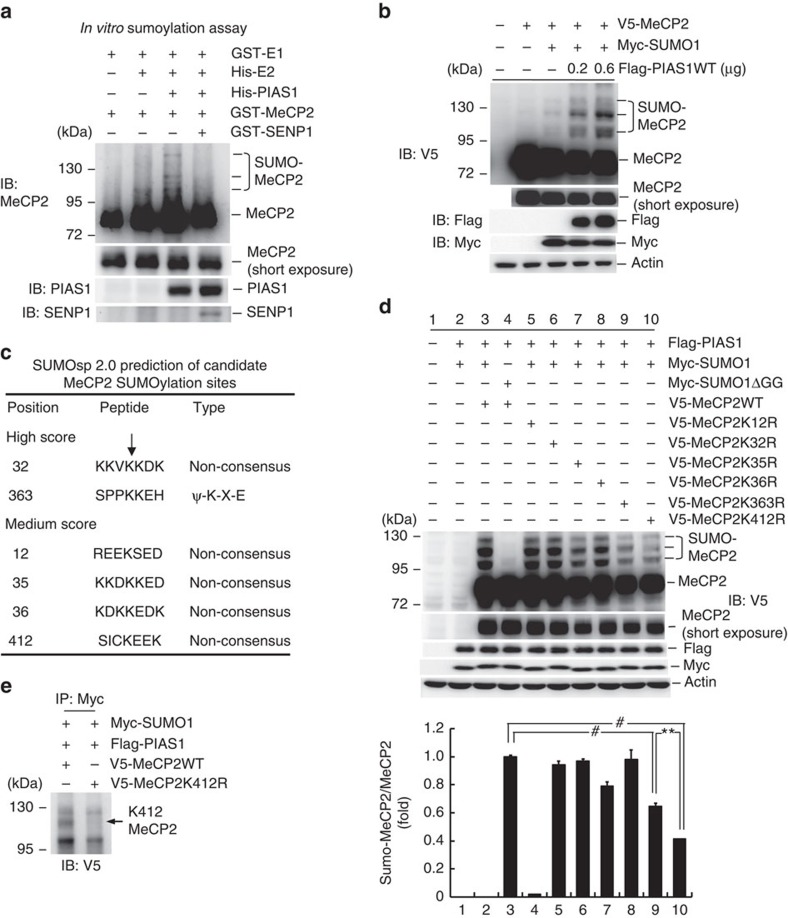
Identification of candidate SUMO sites on MeCP2.(a) In vitro SUMOylation assay showing MeCP2 SUMOylation by PIAS1. Purified GST-E1, His-E2, His-PIAS1, GST-MeCP2 and GST-SENP1 proteins were added to the reaction for this assay. (b) V5-MeCP2 and Myc-SUMO1 plasmids were co-transfected with different amounts of Flag-PIAS1 plasmid to HEK293T cells confirming MeCP2 SUMOylation by PIAS1. (c) SUMO2.0 Software prediction of candidate SUMO acceptors on MeCP2. The ‘K' letter indicated by the arrow represents the candidate SUMO sites. (d) Flag-PIAS1 and Myc-SUMO1 (or Myc-SUMO1ΔGG) plasmids were co-transfected with V5-MeCP2WT or different V5-MeCP2 lysine mutant plasmids to HEK293T cells. MeCP2 SUMOylation was examined by immunoblotting using anti-V5 antibody. The quantified result is shown in the lower panel (n=2 each group; F9,10=240.59, #P<0.001; q=12.73, #P<0.001 comparing lane 3 versus lane 9; q=21.1, #P<0.001 comparing lane 3 versus lane 10; q=8.37, **P<0.01 comparing lane 9 versus lane 10, one-way ANOVA followed by Newman–Keul post hoc multiple comparisons). (e) V5-MeCP2 or V5-MeCP2K412R plasmid was co-transfected with Myc-SUMO1 and Flag-PIAS1 plasmids to HEK293T cells. The cell lysate was immunoprecipitated with anit-Myc antibody and immunoblotted with anti-V5 antibody for confirmation of MeCP2 SUMOylation at Lys-412. The arrow indicates MeCP2 SUMOylation at Lys-412. All experiments are in two repeats. Data are expressed as mean±s.e.m.